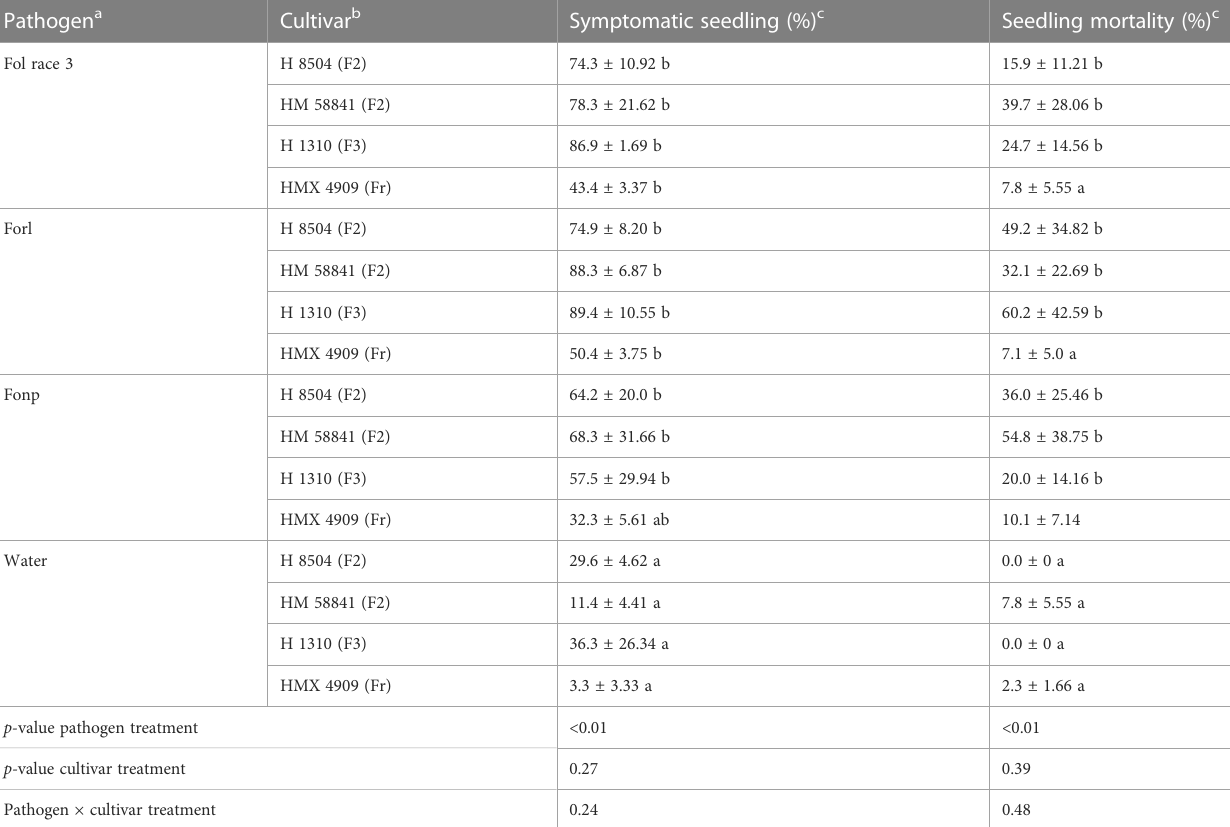
TABLE 3 Phenotyping with a rapid seedling laboratory bioassay of four tomato cultivars inoculated with different formae specialis Fusarium oxysporum strains. Pathogen